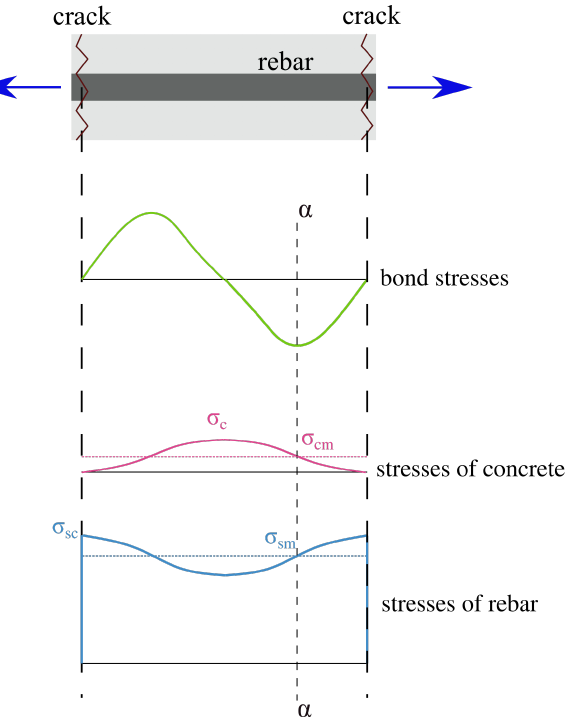
Figure 10. Stress distributions in reinforcement bar in concrete